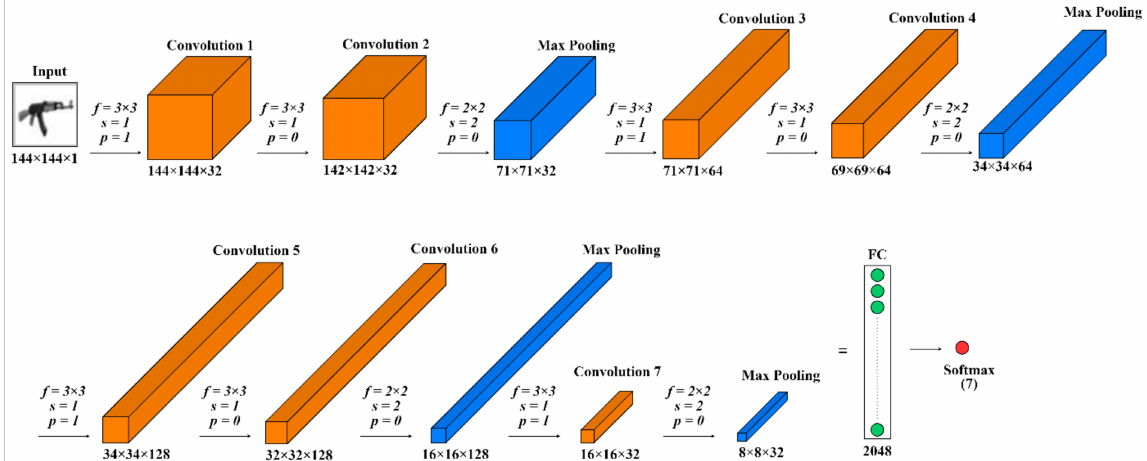
Figure 2. Developed convolution neural network model (f: filter size, s: stride, p: padding, FC: fully